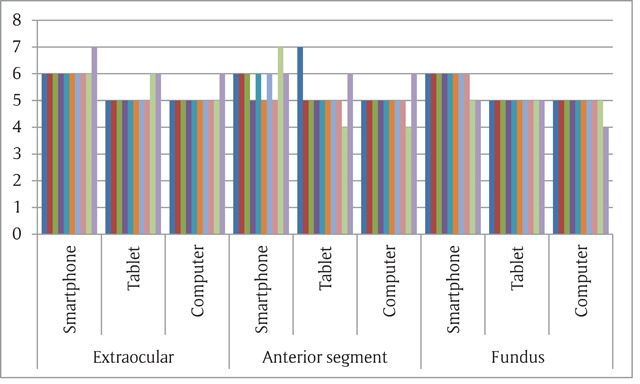
Average likert score for all the 30 images on different devices.